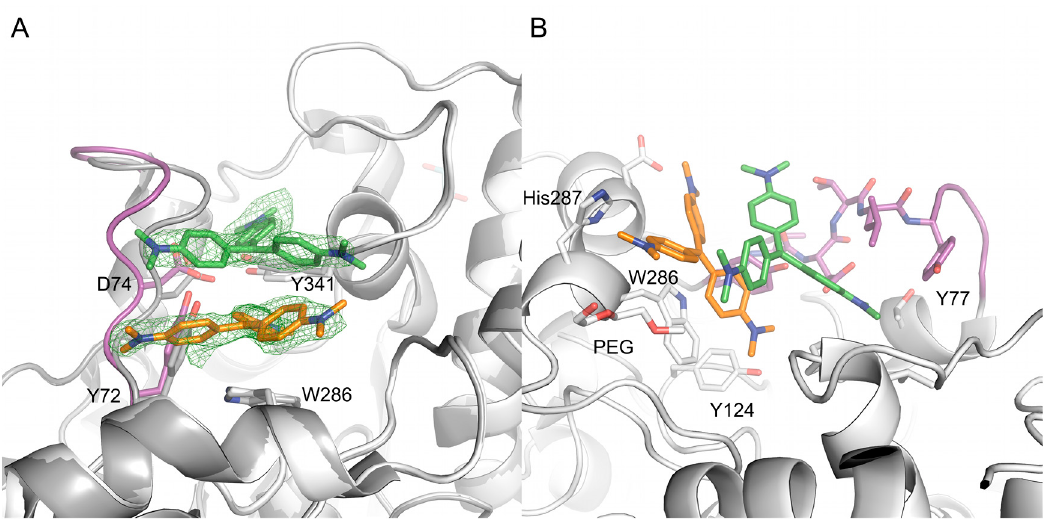
Figure 3. The electron density map clearly defines CV1 (orange) and CV2 (green) binding at the entrance of the active site gorge ( A ); The binding of CV1 and CV2 involves an extensive interface, with high shape complementarity ( B ). In the picture, the 72–80 loop region is shown in magenta, and the apo form of AChE is shown in dark grey.